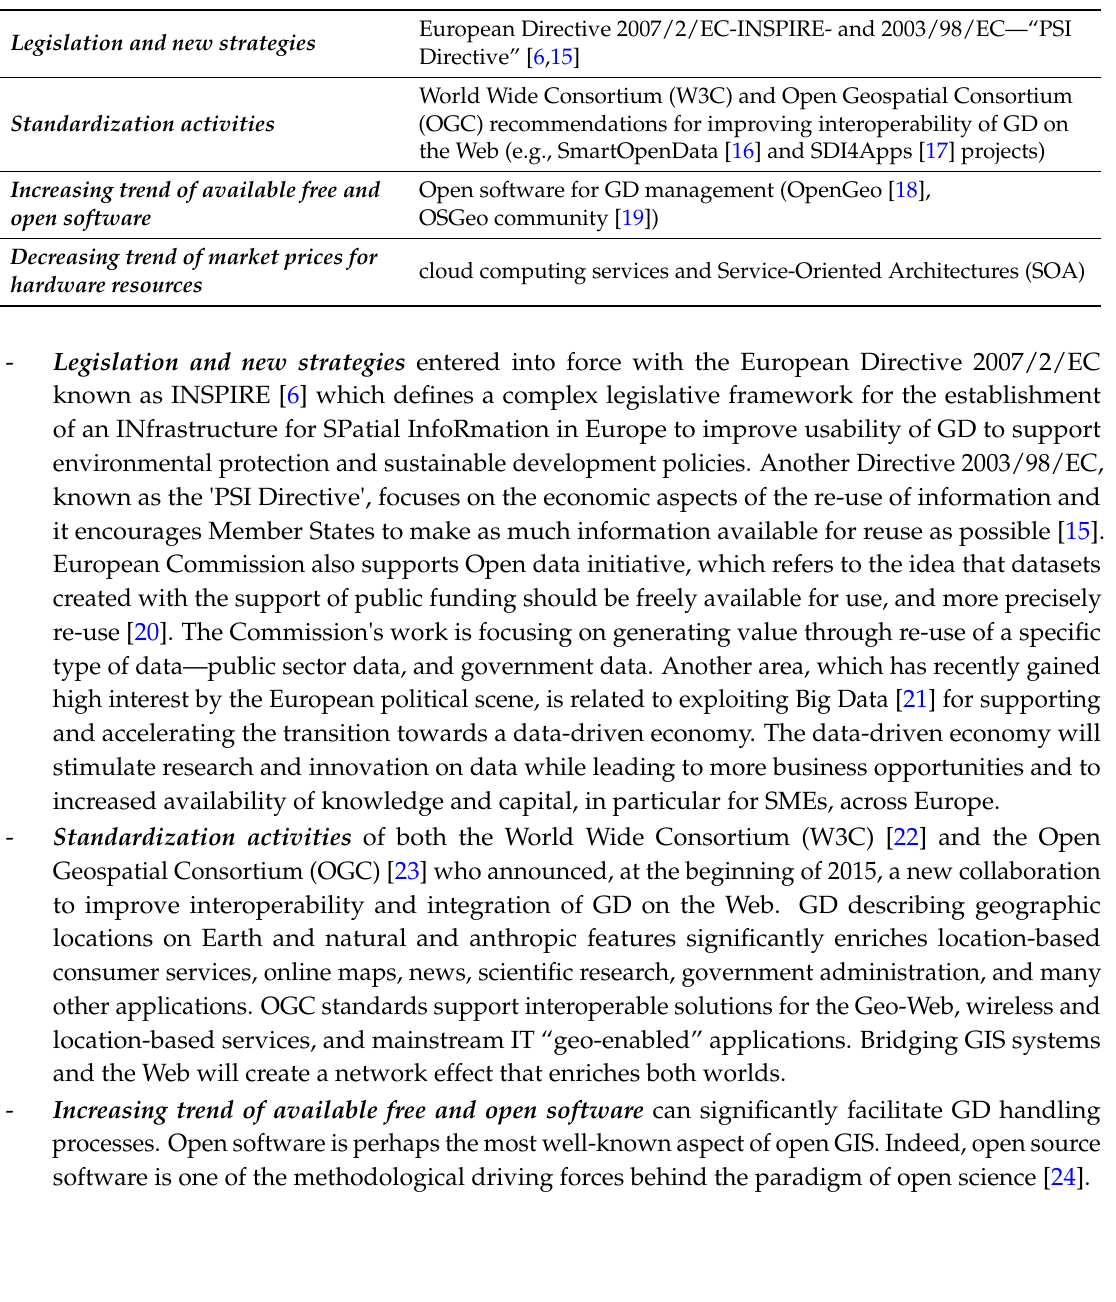
Table 1. Key role factors favoring SDI